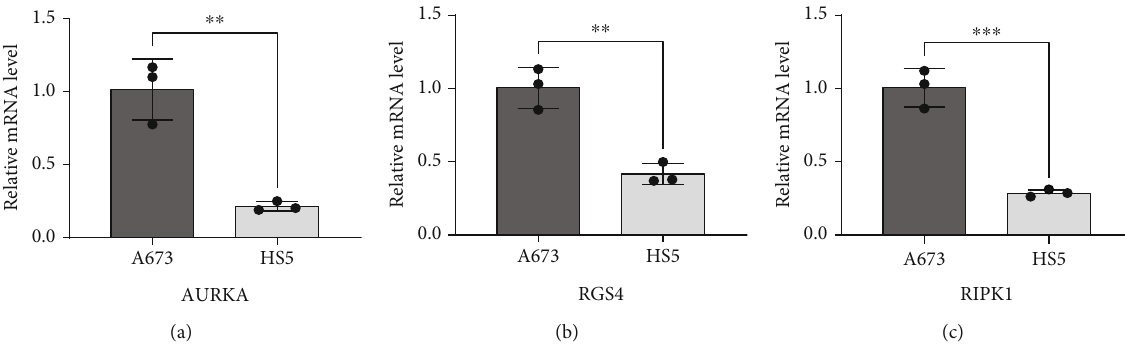
Figure 8: Real-time quantitative PCR (RT-qPCR). Validation of di ff erential expression of 3 key FRG mRNAs between tumor and normal cells. (a) AURKA; (b) RGS4; (c) RIPK1 ( ∗∗ P < 0 : 01 ; ∗∗∗ P < 0 : 001